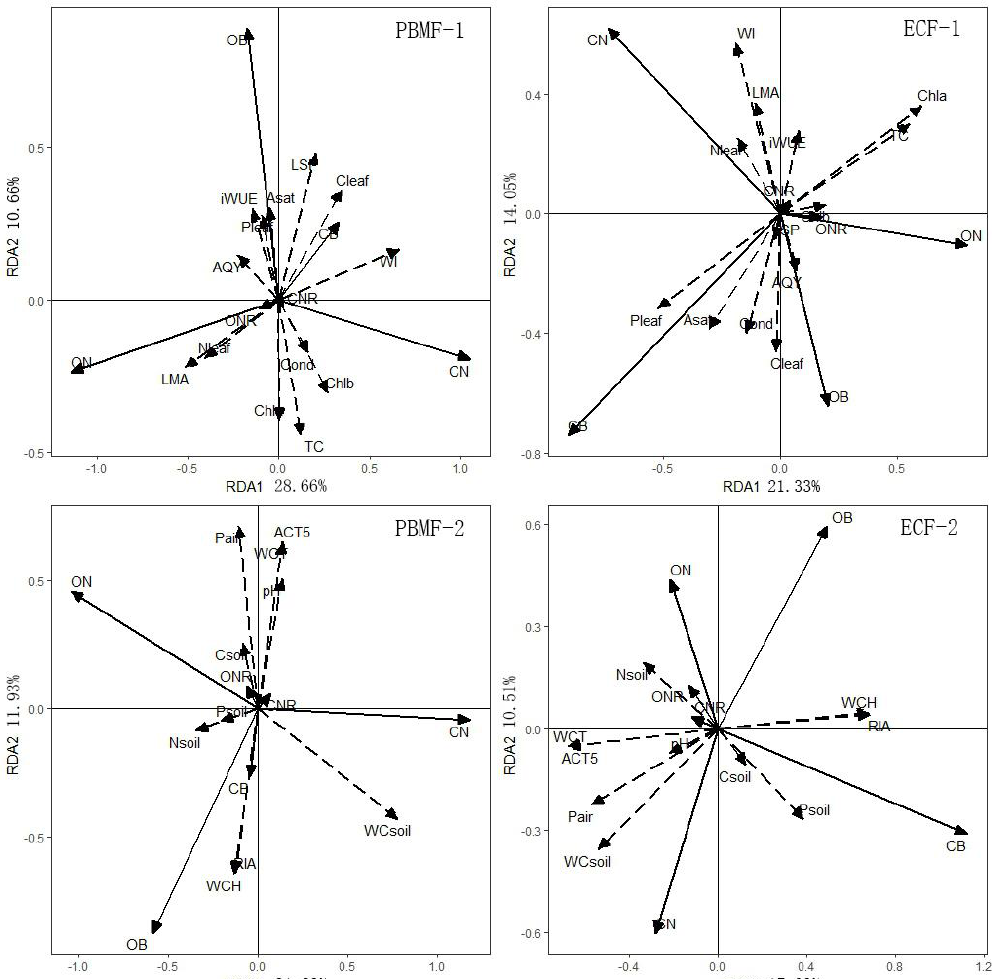
Figure 7. PBMF-1: RDA analysis between growth and needle properties in Pinus koraiensis and mixed broadleaved forests; PBMF-2: RDA analysis between growth properties and environmental factors in Pinus koraiensis and mixed broadleaved forests. ECF-1: RDA analysis between growth and needle properties in evergreen coniferous forests; ECF-2: RDA analysis between growth properties and environmental factors in evergreen coniferous